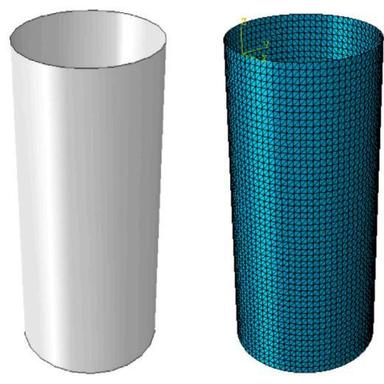
FEM of composite pipe.